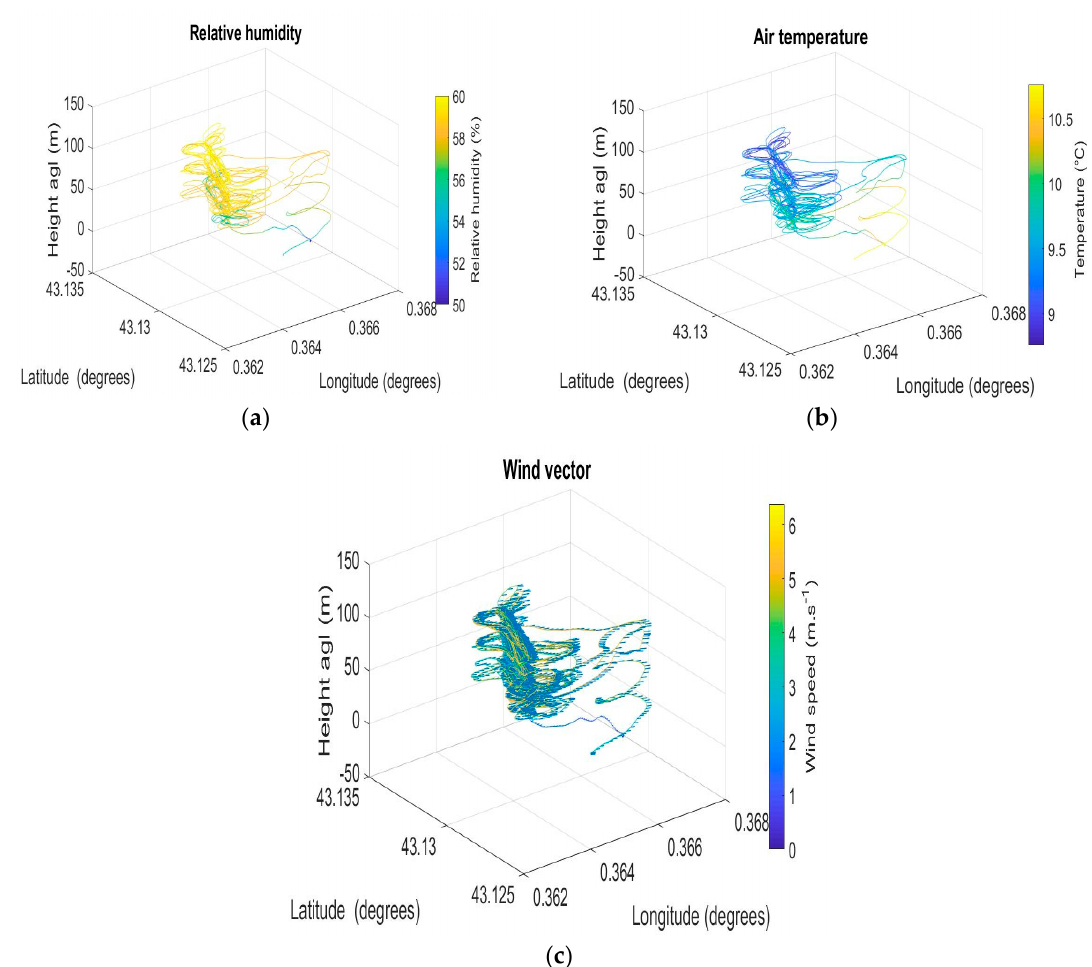
Figure 10. Relative humidity ( a ), temperature ( b ), and wind speed ( c ) measured by OVLI-TA during a